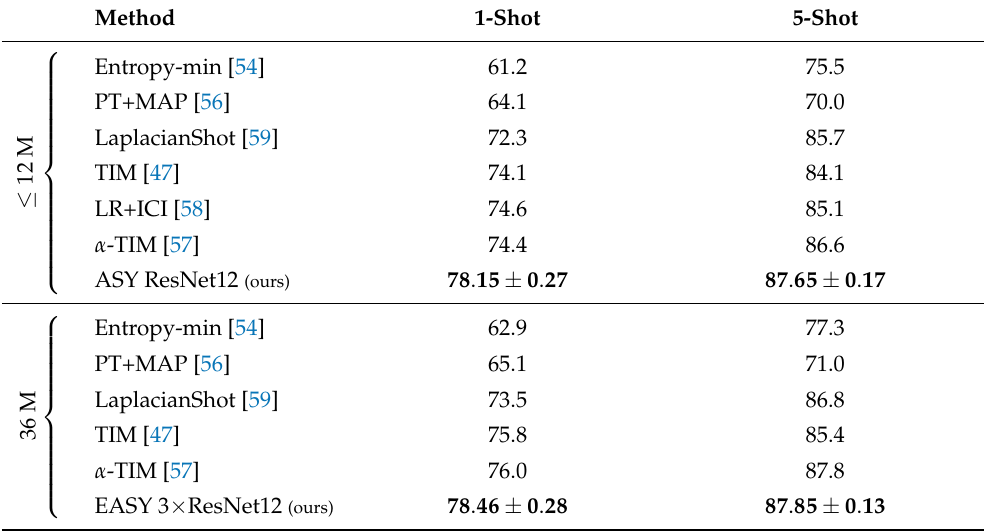
Table A2. The 1-shot and 5-shot accuracy of state-of-the-art methods and the proposed solution on TieredImageNet in the imbalanced transductive setting.